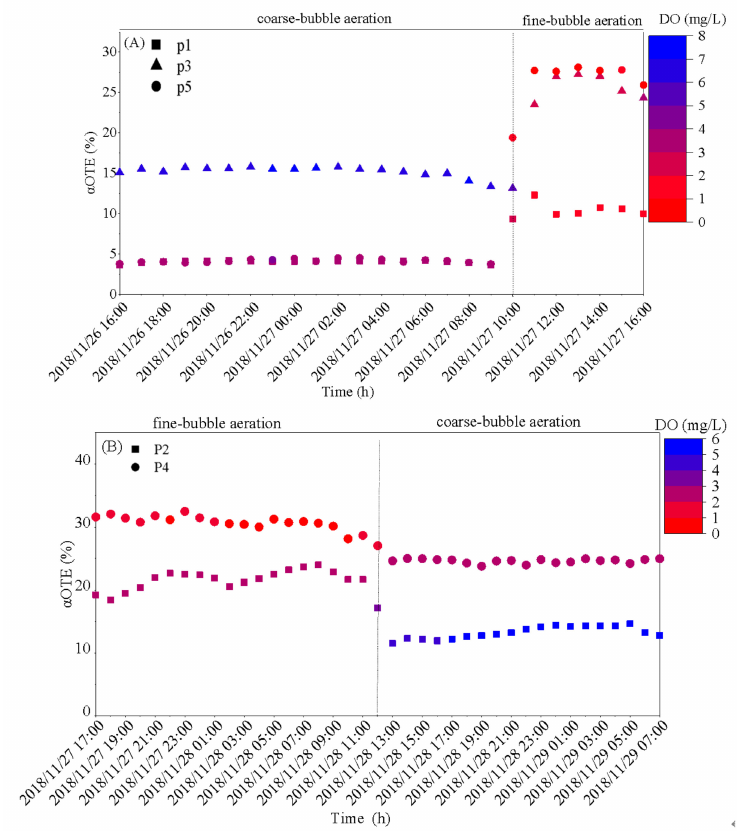
Figure 4. The α OTE of different aeration types at the five